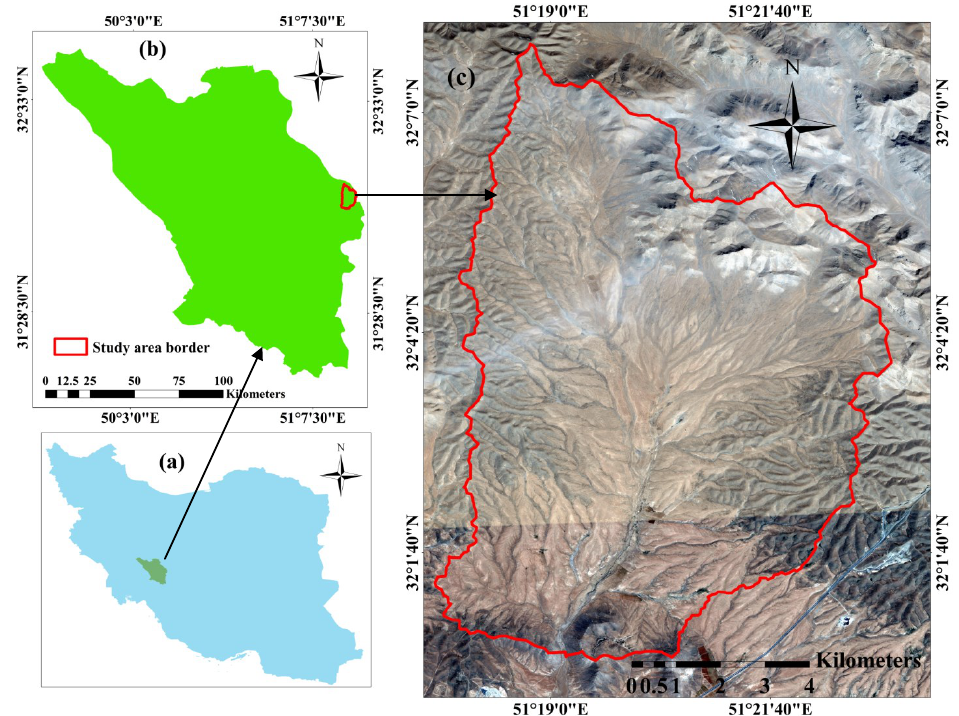
Figure 4. Location of Marjan in the Chaharmahal-Va-Bakhtiari province in southwest Iran: ( a ) Iran border; ( b ) Chaharmahal-Va-Bakhtiari border; ( c ) study area border